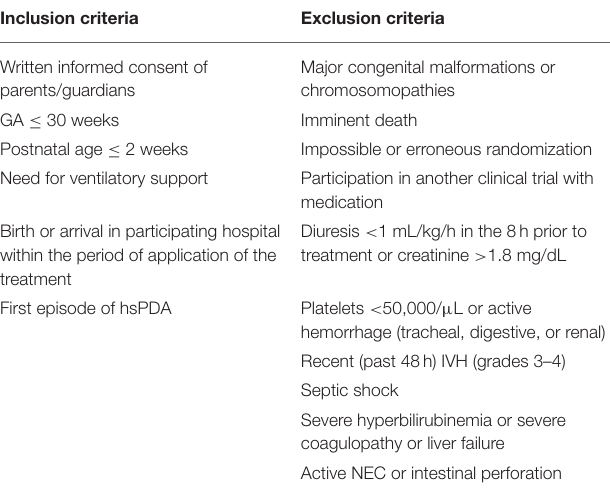
TABLE 2 | Inclusion and exclusion criteria of the study. Inclusion